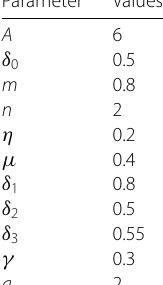
Table 2 Parameter for Figs. 6–10